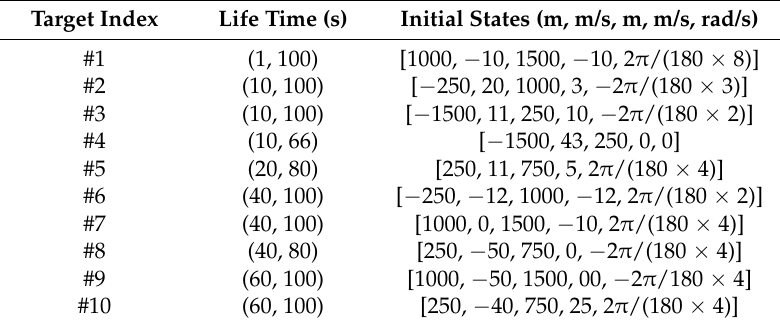
Table 3. A list of initial target